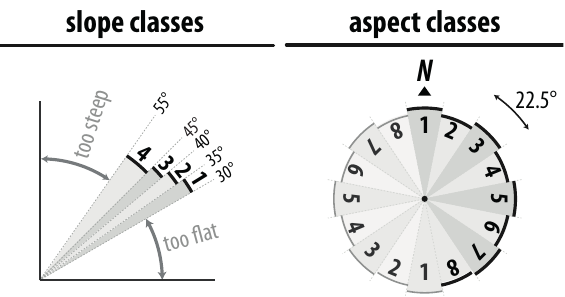
Figure 5. Classification schemes for the four slope classes and eight aspect classes constituting the 32 topoclasses subject to investigation. The slope classification corresponds to the values in Table